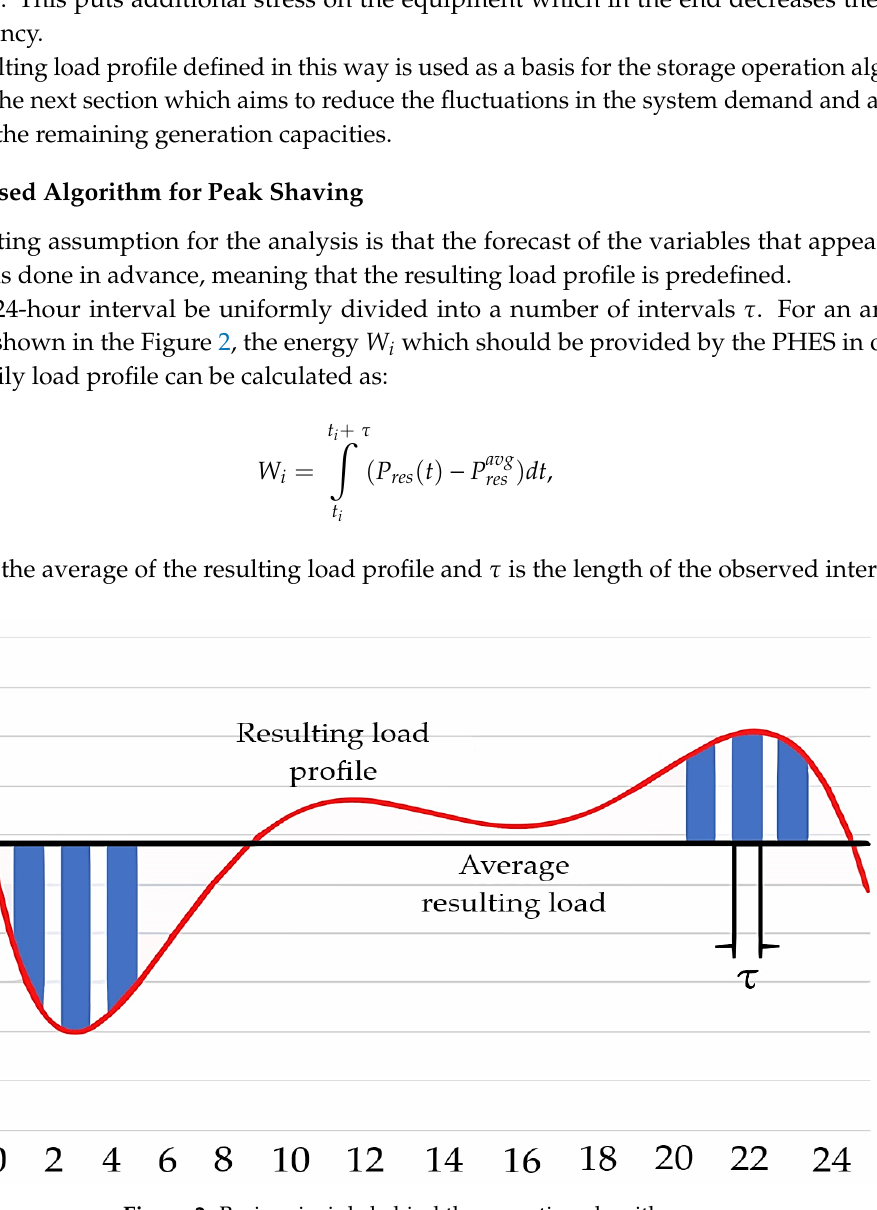
Figure 2. Basic principle behind the operation algorithm.